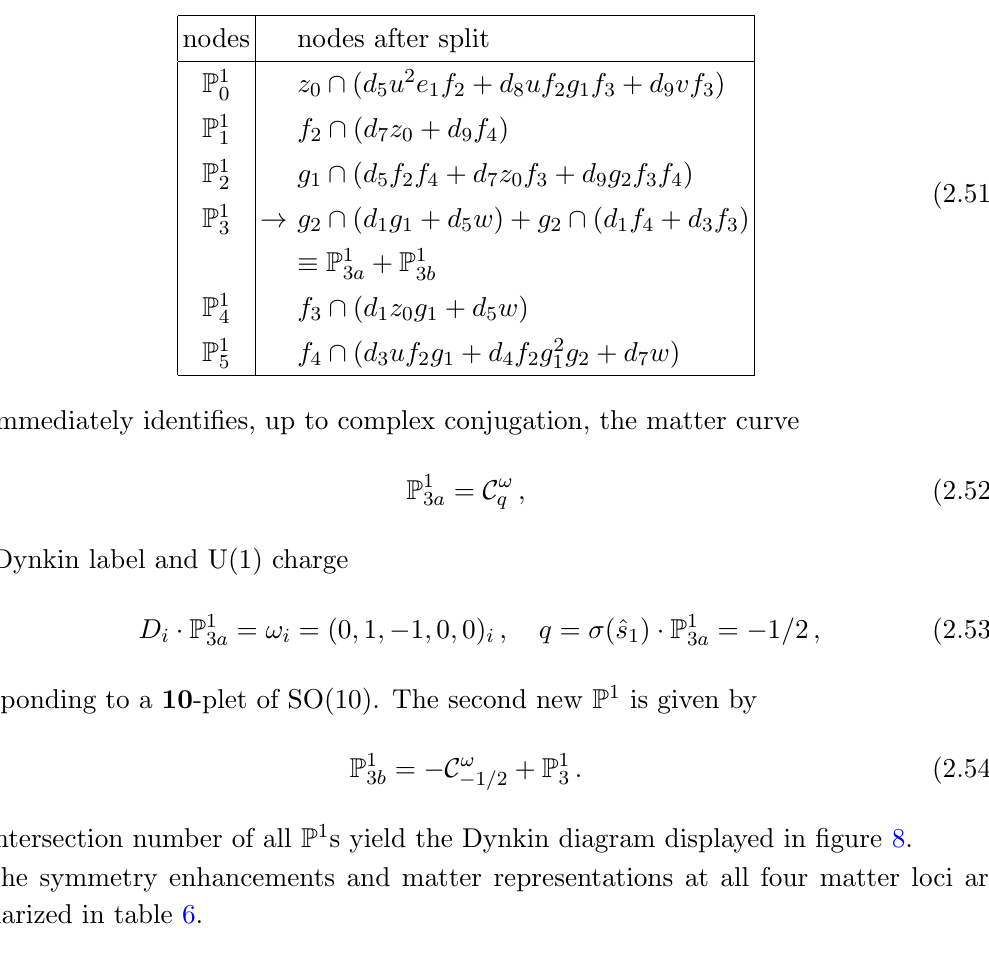
Figure 8 . Extended Dynkin diagram of SO(12) at the d intersects with [ e 1 ]. The dashed ellipse indicates the SO(10) node P 1 Calculating the intersection numbers of all P 1 s one (cid:12)nds again the extended Dynkin diagram of E 6 . This is displayed in (cid:12)gure 7 where also the split of the SO(10) P 1 s is indicated by dashed